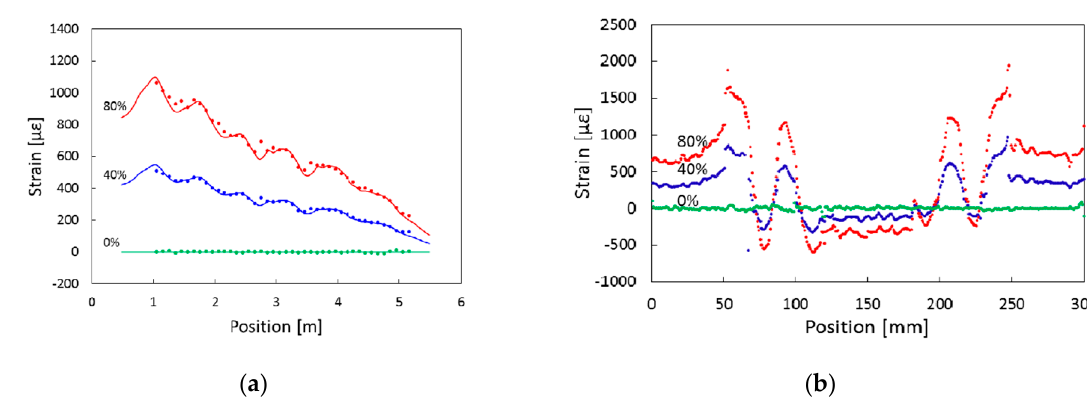
Figure 21. Array layout of FBGs [86].